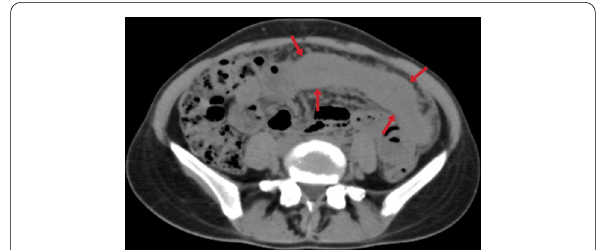
Fig. 33 Transverse CT image without intravenous contrast of a 24-year-old female. Diffuse-symmetric wall thickening of the ileal segment is noted (arrows). Ileal TB